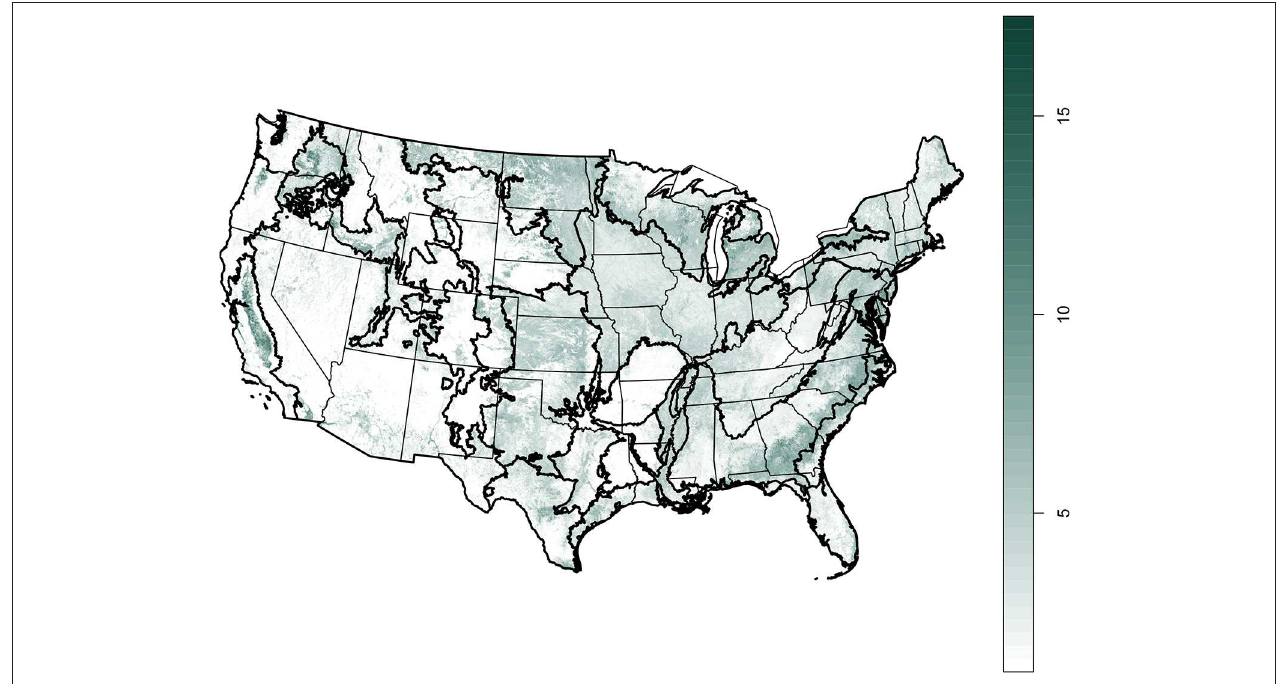
FIGURE 3 | Maximum crop effective richness, 2008–2018.